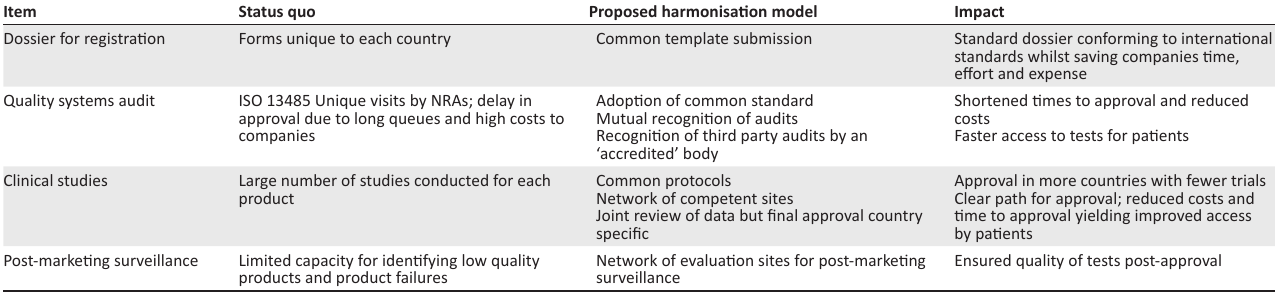
TABLE 3: Expected impact of harmonisation